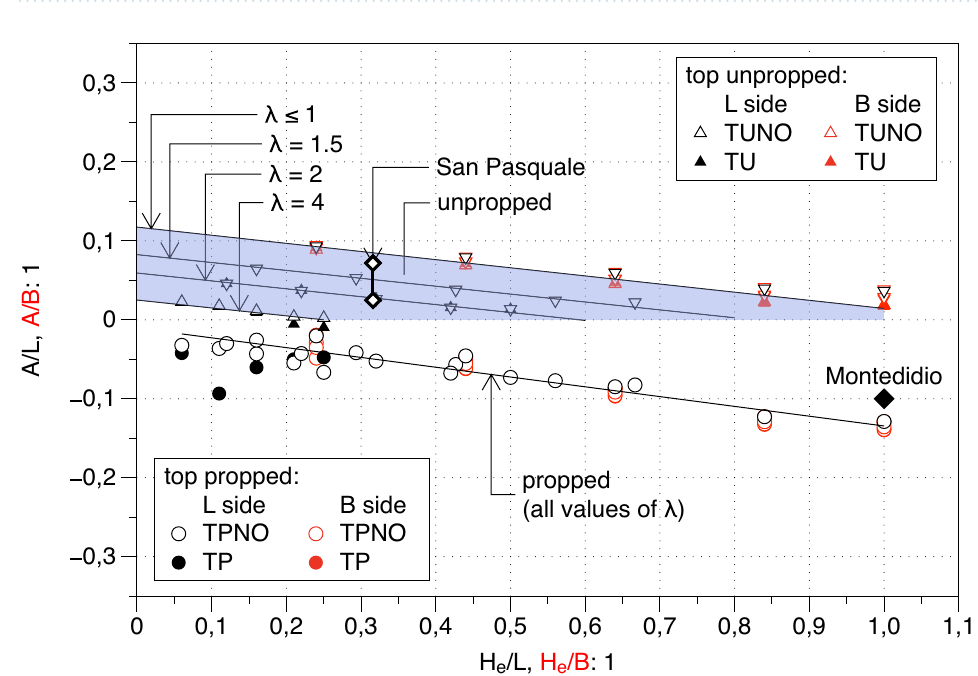
Figure 18. Normalised distance of the inflexion point from the corner of the excavation,